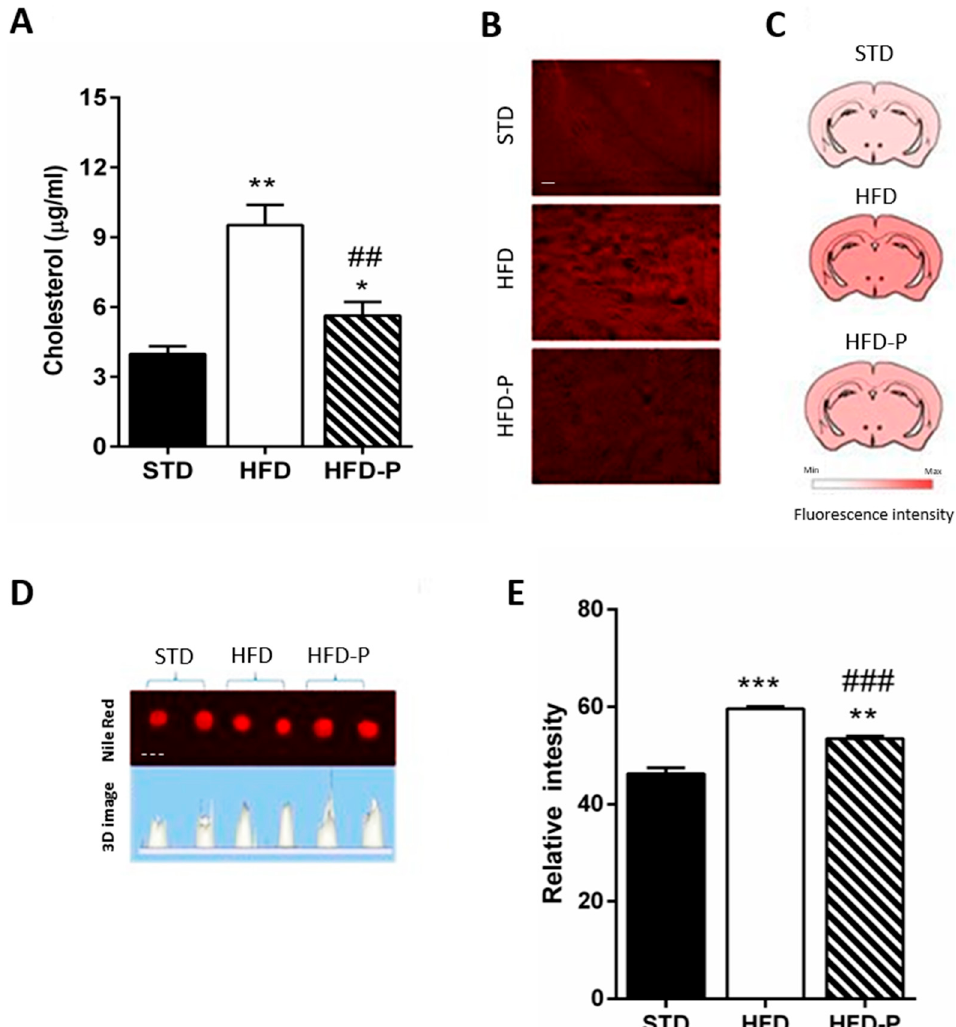
Figure 3. Pistachio consumption prevents HFD-induced brain lipid accumulation. ( A ) cholesterol concentration in brain tissue of STD, HFD, and HFD-P fed mice; ( B ) lipids content measured by Nile Red staining in coronal brain sections of STD, HFD, and HFD-P mice; ( C ) scheme of distribution of Figure 3. fluorescence after Nile Red staining; ( D ) fluorescence in brain lysates of STD, HFD, and HFD-P mice after Nile Red staining; ( E ) quantification of Nile Red staining fluorescence. Data are means ± SEM ( n = 8 / group). * p < 0.05, ** p < 0.01, *** p < 0.001 vs STD. ## p < 0.01, ### p < 0.001 vs HFD. Microscope magnification 20 × . Continuous line, Bar: 100 µ m. Dashed line, Bar: 5